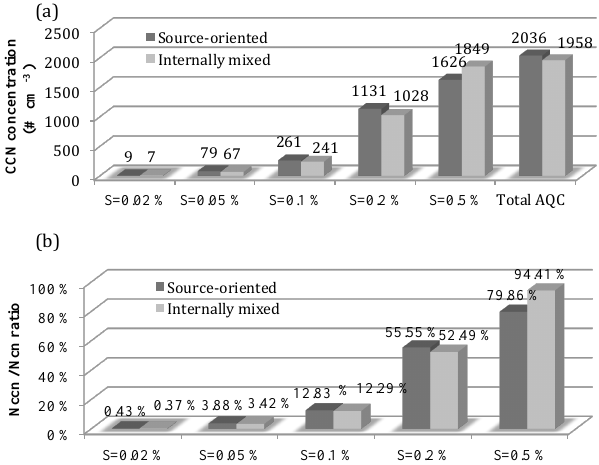
Figure 11. (a) 72h averaged CCN concentration at supersaturation of 0.02, 0.05, 0.1, 0.2, 0.5% and total AQC concentration with units in no. cm − 3 . (b) N CCN /N CN ratio at five corresponding supersat- urations. Dark gray is the source-oriented experiment and light gray represents the internally mixed experiment. Results are average val- ues using data within the first five model